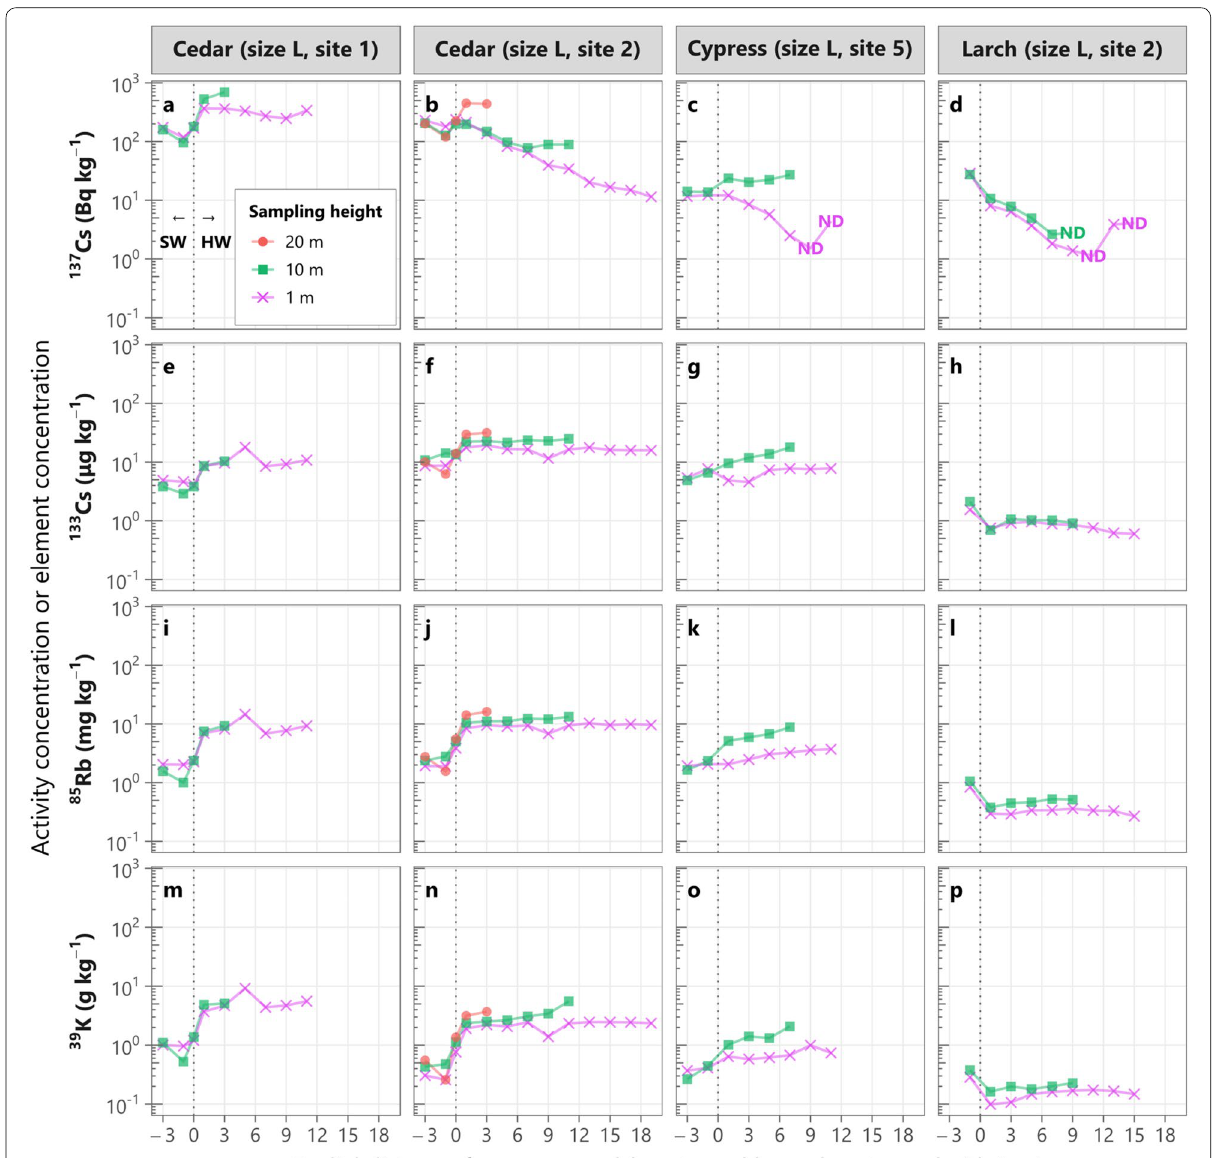
Fig. 3 Radial distribution of element (activity) concentration in wood sampled at different vertical positions in 2014. a – d 137 Cs, e – h 133 Cs, i – l 85 Rb, m – p 39 K. ND letters indicate that 137 Cs activity in the samples was under the detection limit and show the detection limit values. SW sapwood,